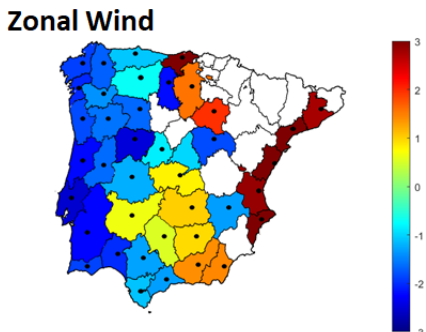
Figure 5. Standardized anomalies of the zonal wind velocity for the large fires days under FWT2 (fire weather type 2) conditions in each province. The point indicates whether the fire weather type represented is statistically significant at the province level (Kruskal–Wallis non-parametric test with 95% significance). Provinces with very few large fires are represented in white and were disregarded.